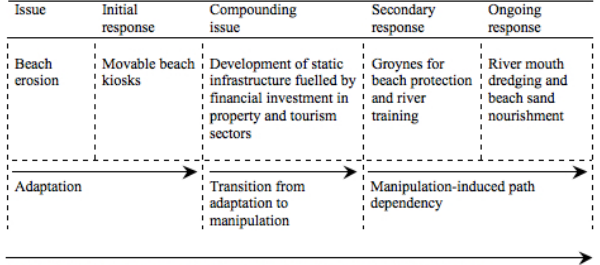
Fig. 2. Response shift from adaptation to manipulation, Noosa Main